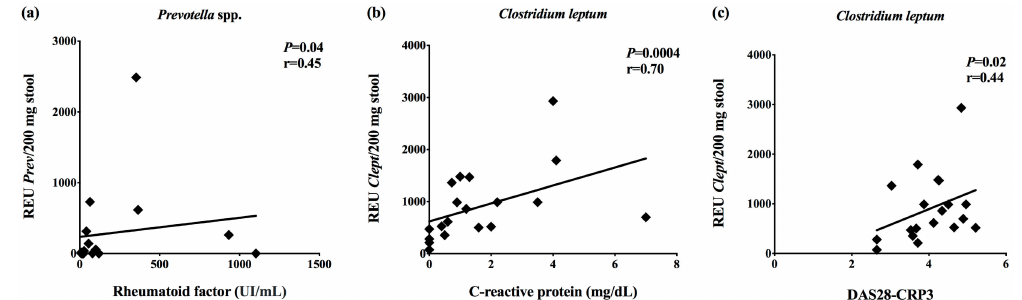
Figure 2. Spearman’s correlation between the relative expression units (REU) of the gut bacteria and clinical data. ( a ) Relative expression units of Prevotella species and rheumatoid factor concentrations, ( b ) REU of Clostridium leptum and C-reactive protein levels, and ( c ) REU of Clostridium leptum and the disease score DAS28-CRP3.